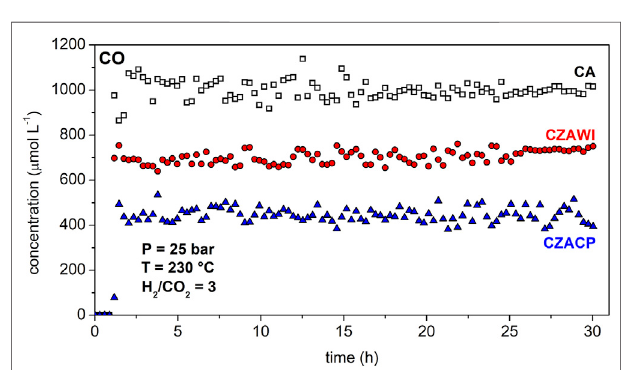
FIGURE 10 | CO 2 conversion with time using CA, CZAWI, and